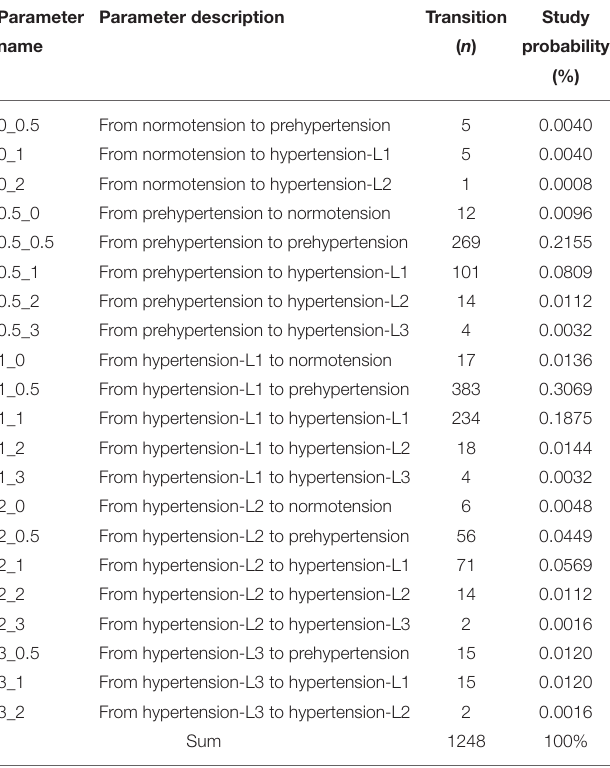
TABLE 3 | Original transition probabilities among different levels of hypertension during the intervention period of the CMB–OC trial. Parameter Parameter